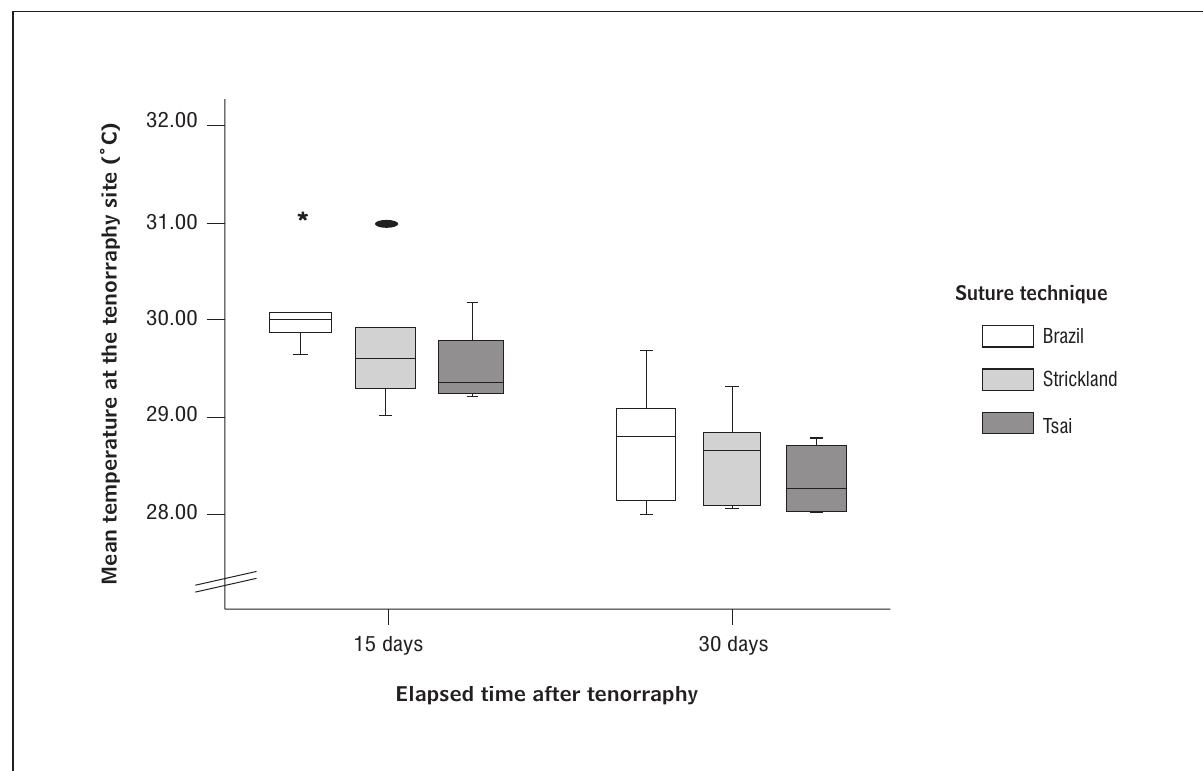
Figure 3 - Maximum temperature (°C) measured at the site of the tenorraphy: on the 15 th and 30 th days after the completion of the different